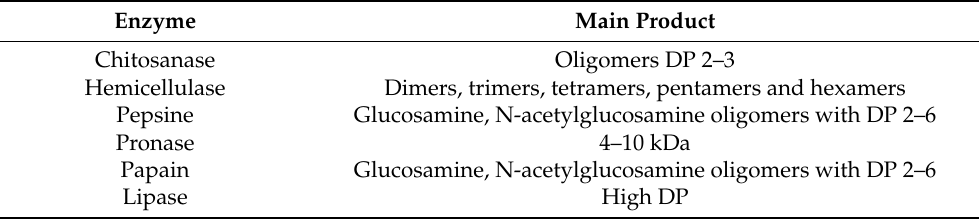
Table 2. The main products produced in the enzymatic degradation of